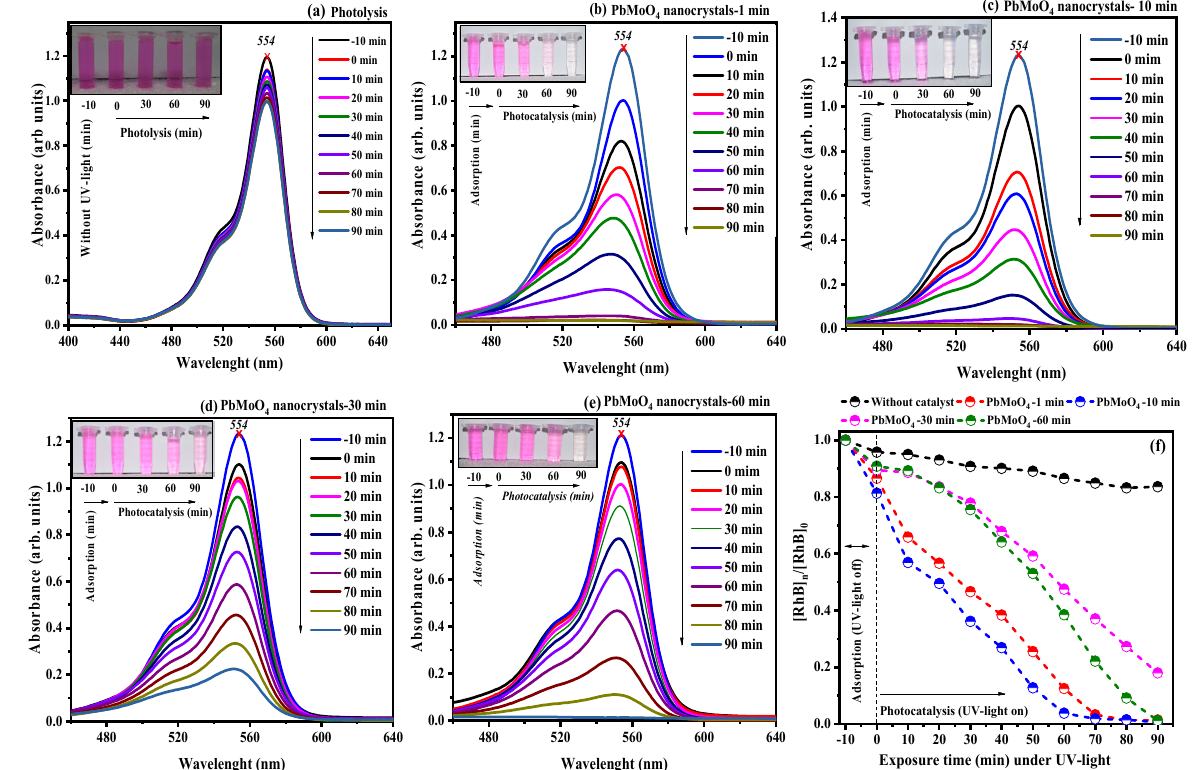
Figure 7. The evolution of photocatalytic degradation of RhB dye (cationic) under ( a ) UV light and ( b – e ) using the PbMoO 4 nanoparticles. Figure ( f ) represents all experiments’ concentration vs. exposure time under UV light.